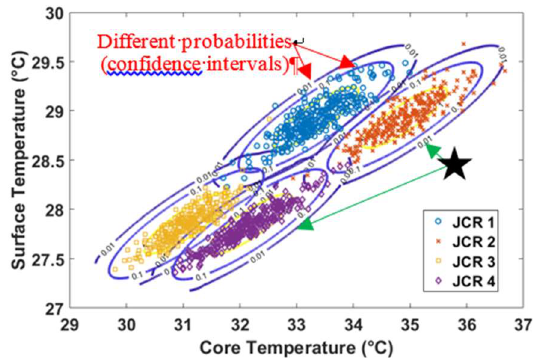
Figure 8. JCRs generated with a set of specific mean values of I and R c , which are summarized in Table A1 in Appendix B. (i) JCR 1: 16.2 and 1.68 for I and R c ; (ii) JCR 2: 16.2 and 2.28 for I and R c ; (iii) JCR 3: 13.8 and 1.68 for I and R c ; (iv) JCR 4: 13.8 and 2.28 for I and R c .